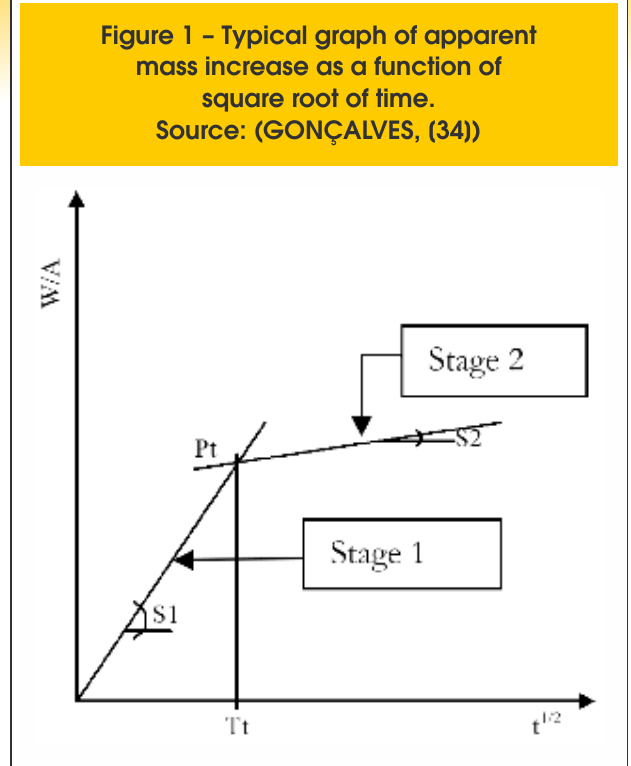
Figure 1 – Typical graph of apparent mass increase as a function of square root of